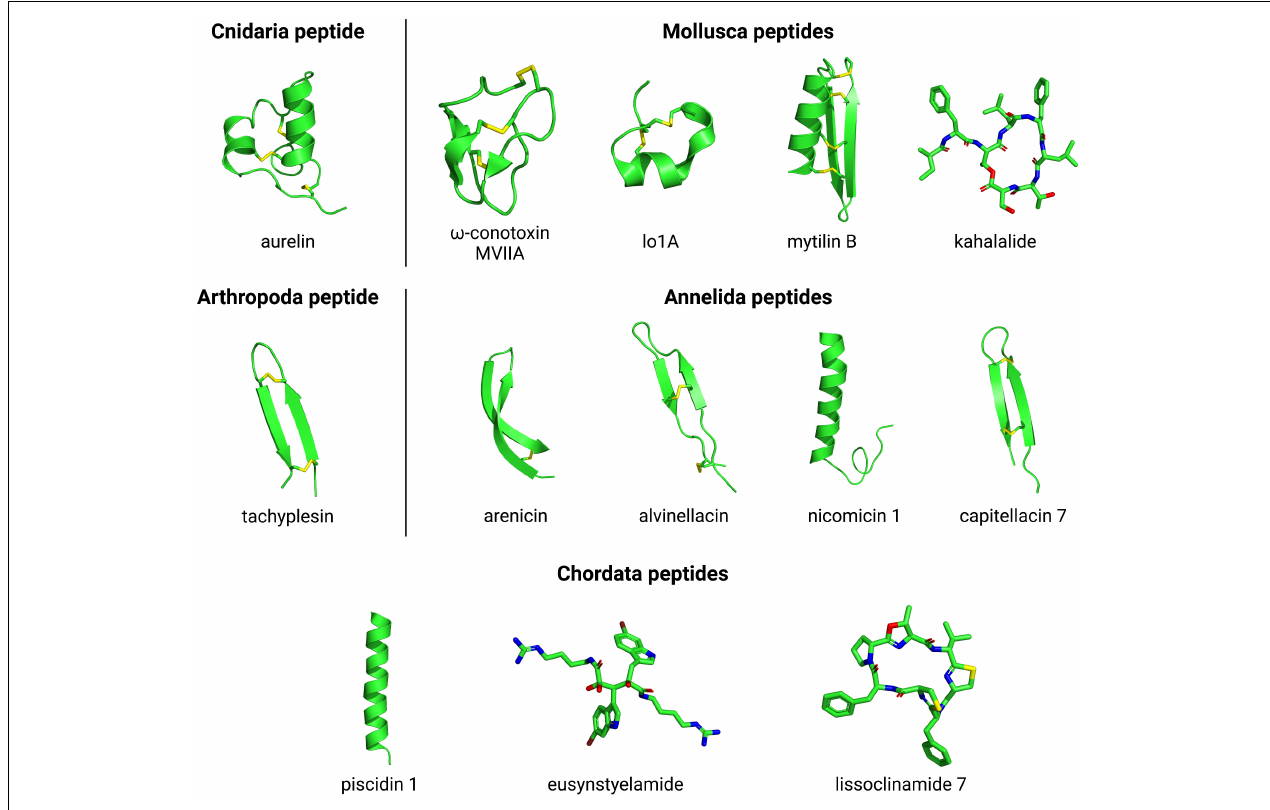
FIGURE 5 | Three-dimensional structures of Cnidaria, Mollusca, Arthropoda, Annelida, and Chordata peptides. The evaluated structures include aurelin (PDB ID: 2LG4) from Cnidaria; omega-conotoxin MVIIA (PDB ID: 1MVI), lo1A (PDB ID: 2MD6), mytilin B (PDB ID: 2EEM) and kahalalide (PubChem ID: 72942) from Mollusca; tachyplesin (PDB ID: 2RTV) from Arthropoda; arencin (PDB ID: 2JSB), alvinellacin (PDB ID: 2LLR), nicomicin 1 (PDB ID: 6HN9) and capitellacin 7 (PDB ID: 7ALD) from Annelida; and piscidin 1 (PDB ID: 2MCV), eusynstyelamide (PubChem ID: 23427997) and lissoclinamide 7 (PubChem ID: 390558) from Chordata. The PubChem.sdf files were parameterized using Maestro v. 11.6.013 (Schrodinger) and further visualized on PyMOL v. 1.8. The three-dimensional structure images were generated on PyMOL v.